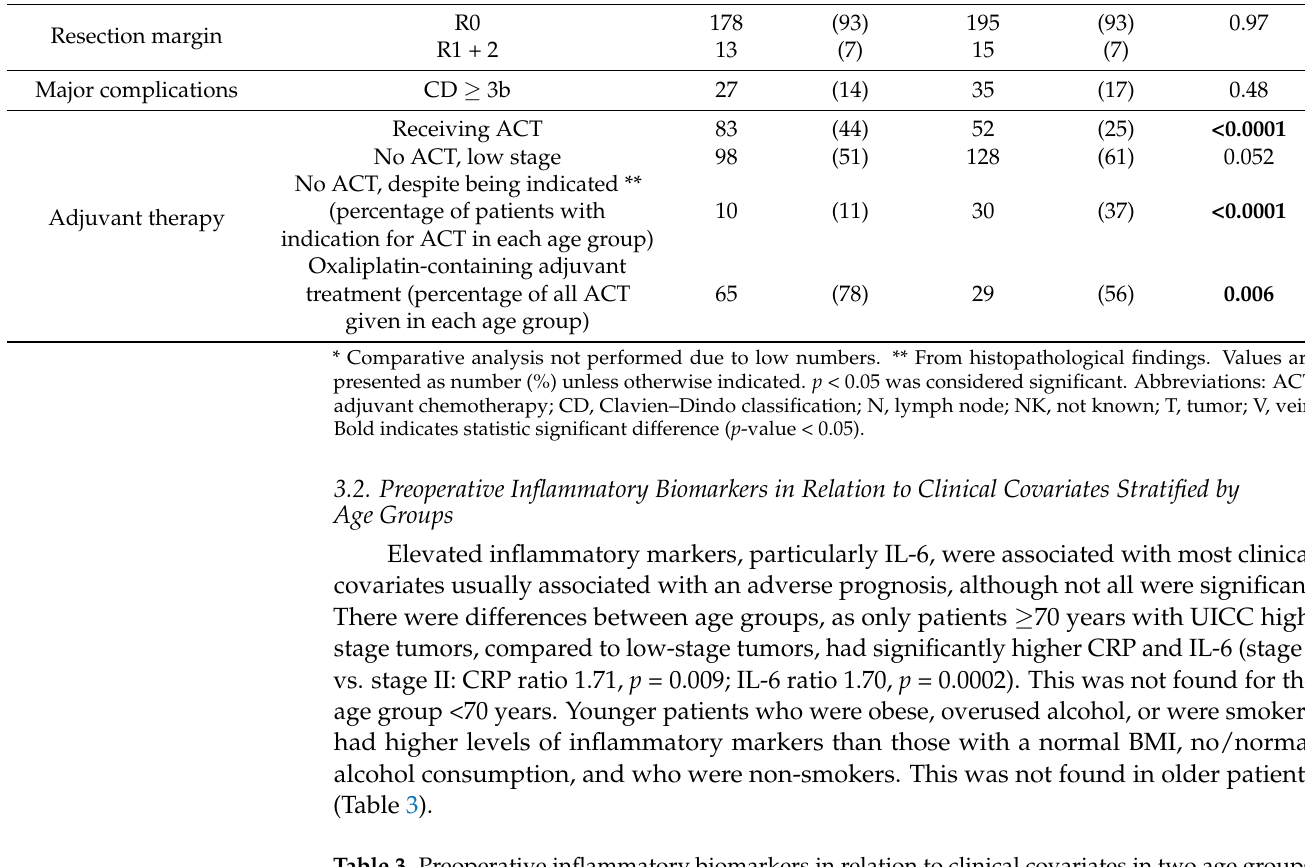
Table 3. Preoperative inflammatory biomarkers in relation to clinical covariates in two age groups, <70 years and ≥ 70